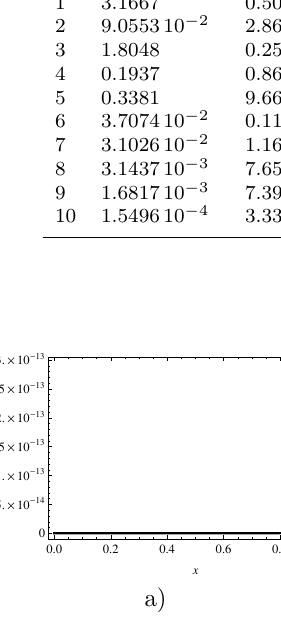
Figure 6. Distribution of error of the exact solution approximation for n =